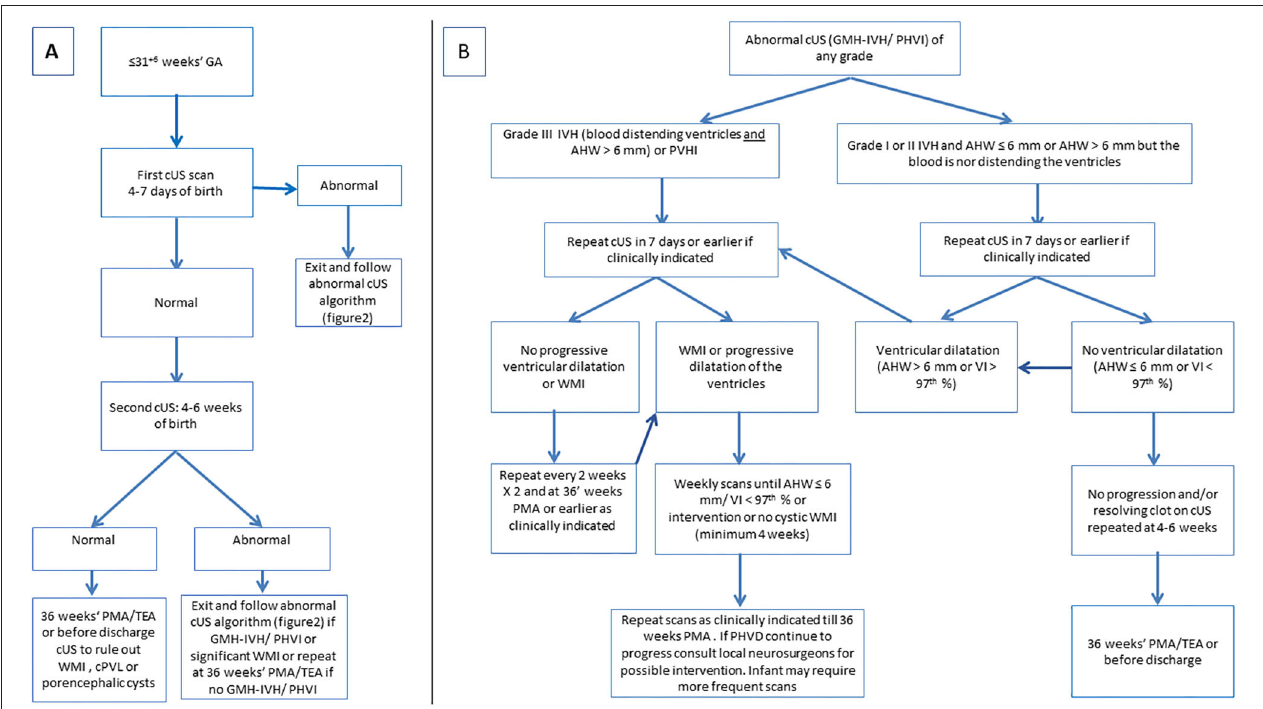
FIGURE 14 | (A) Algorithm for routine cranial ultrasound screening for infants born at or equal to 31 weeks’ gestation. (B) Algorithm for cUS scenario of abnormal cUS findings.